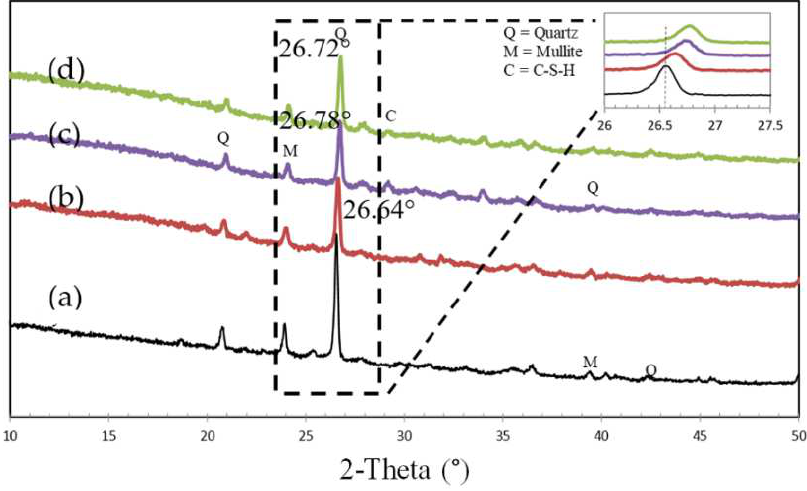
Figure 9. XRD patterns of geopolymer cement: ( a ) fly ash, ( b ) Geo N-8, ( c ) Geo N-10, and ( d ) Geo N-12. All XRD patterns show similar behavior. The presence of mineral quartz is observed with the peaks at 26.64 ◦ , 26.78 ◦ , and 26.72 ◦ (2 θ , CuK α ) in geopolymers with sodium silicate Geo N-8, Geo N-10, and Geo N-12, respectively. The intensity of the X-ray diffraction patterns of the geopolymer with sodium silicate shows nearly similar bands to fly ash (Figure 9a), which is related to the formation of geopolymer networks in all specimens. The intensity of this broad hump is higher on the XRD patterns of sodium silicate with 10 M NaOH (Figure 9c). Mineral phases, mullite, and quartz were visible in the geopolymer XRD patterns, indicating that these minerals remain present during the geopolymerization